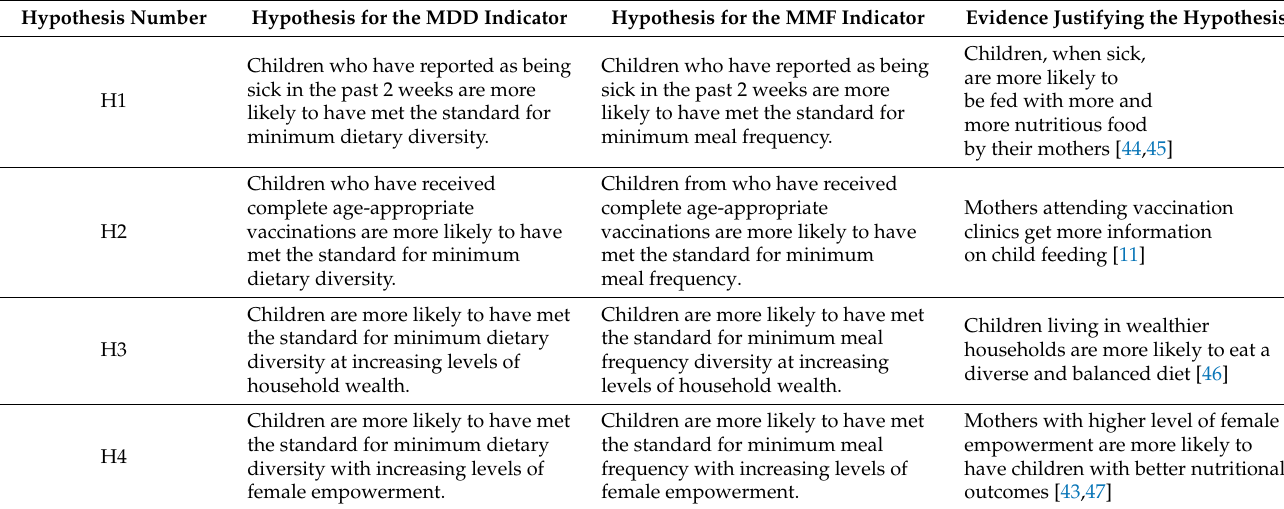
Table 3. Hypotheses formulated for this